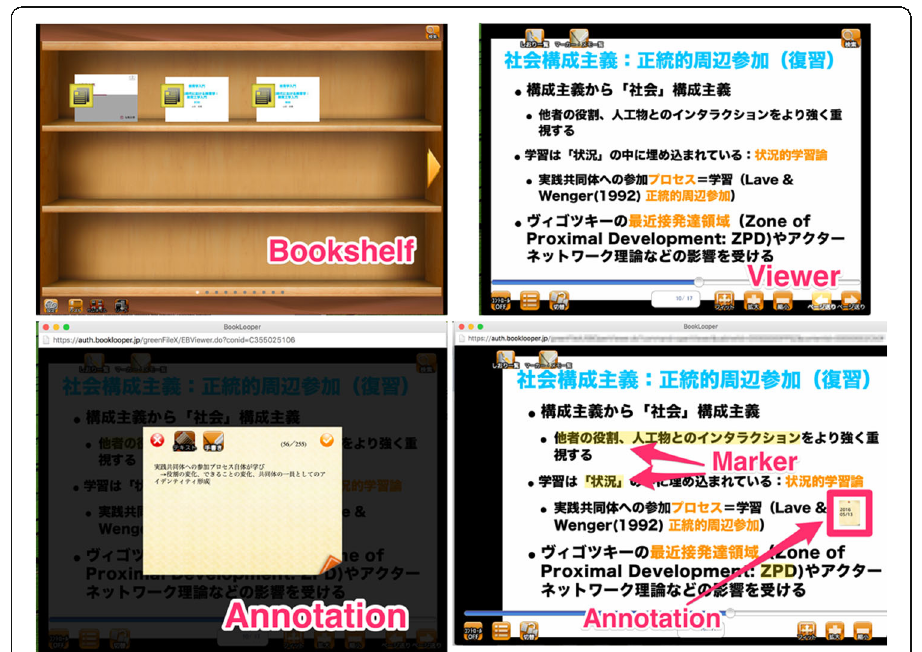
Fig. 1 The interface of DLMR “ BookLooper